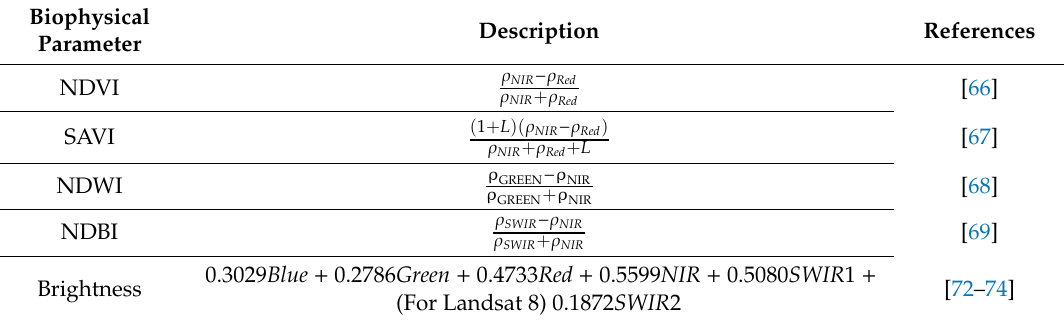
Table 1. Description of surface biophysical